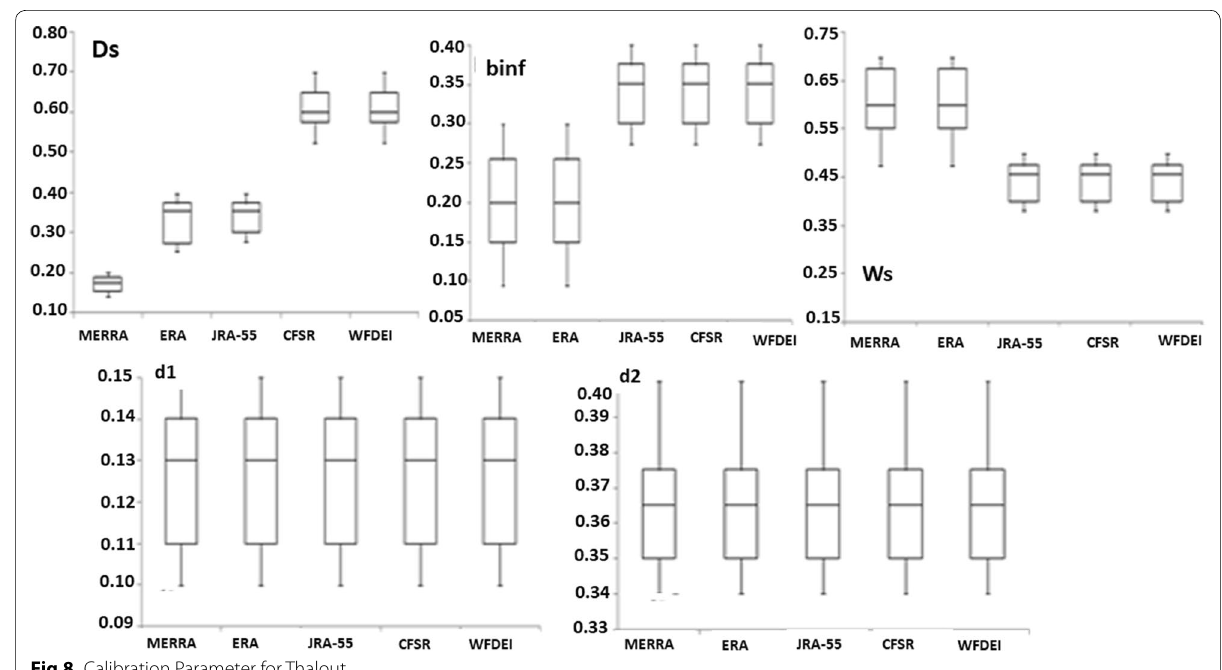
Fig.8 Calibration Parameter for